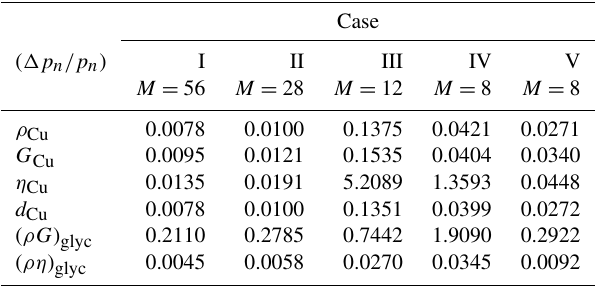
Table 3. Uncertainties of material–geometry parameters of the ma- terial system described in Sect. 3.3. The columns are related to five different combinations of